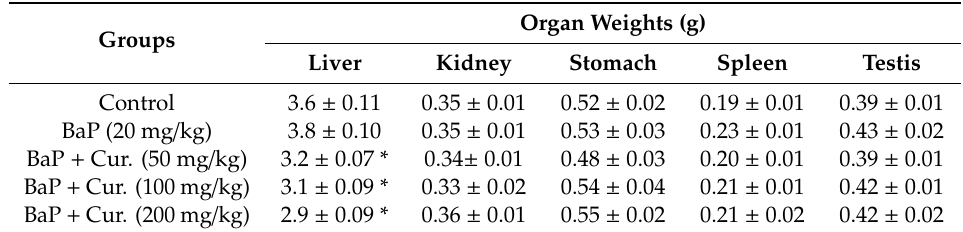
Table 2. E ff ects of Curcumin on Serum Biochemical Parameters in Sprague-Dawley Rats. Table 1. Effects of Curcumin on Organ Weight Changes in Sprague-Dawley Rats. Groups